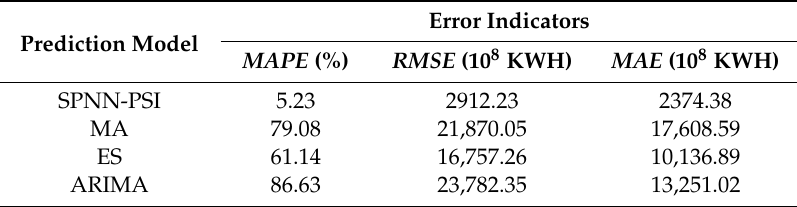
Table 4. Error indicators of each prediction model on the CEO dataset.